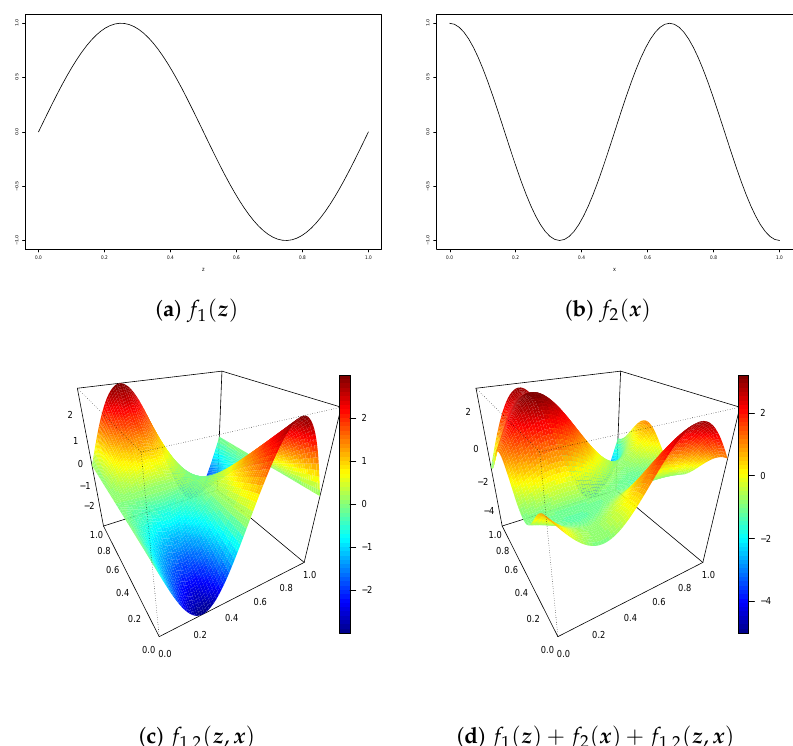
Figure 8. Functions ( a , b ) are the nonlinear main effects of z and x , ( c ) is the interaction surface and ( d ) is the sum of the main effects and the interaction surfaces. The constraint imposed is that the coefficients of the fit remain invariant when out- of-sample-prediction is performed. In all cases, smoothing parameters are estimated using